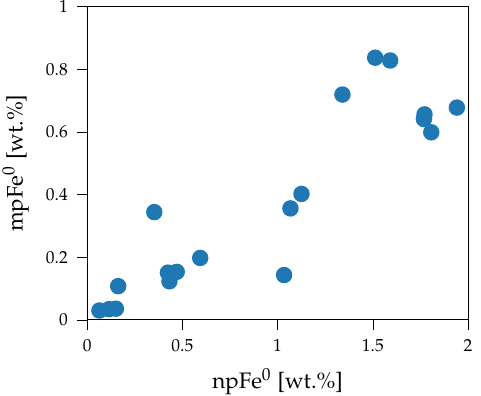
Figure 27. The correlation between the mean predicted npFe 0 and mpFe 0 abundance is r = 0.90. Therefore, with increasing npFe 0 abundance typically also the mpFe 0 abundance increases. The factor npFe approximately amounts to mpFe